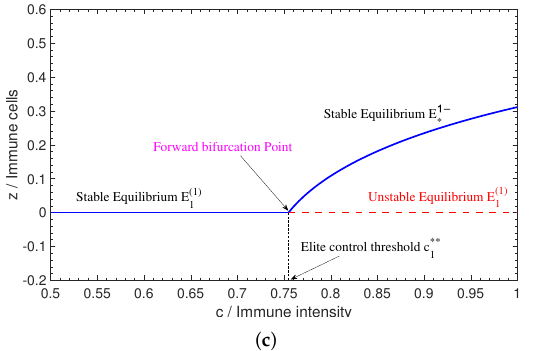
Figure 2. Bifurcation diagrams of system (1) where the vertical axis represents Activated CD4 + T cells (see ( a )), Infected CD4 + T cells (see ( b )) and Immune cells (see ( c )). The parameter values are listed in Table 3 and α = 10. The solid line represents stable equilibria, and the dotted line represents ≈ 0.7549 unstable equilibria. The elite control threshold is c ∗∗ 1